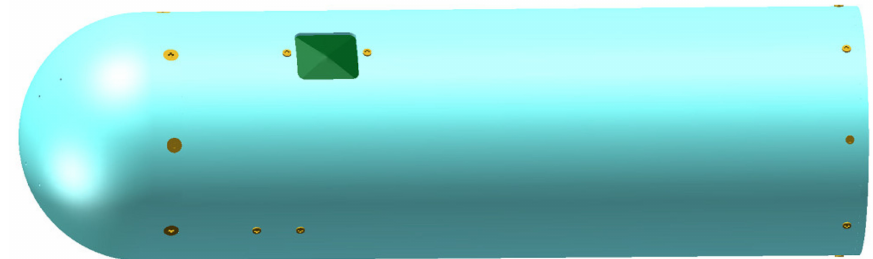
Figure 2. Structure of the flush air data sensing